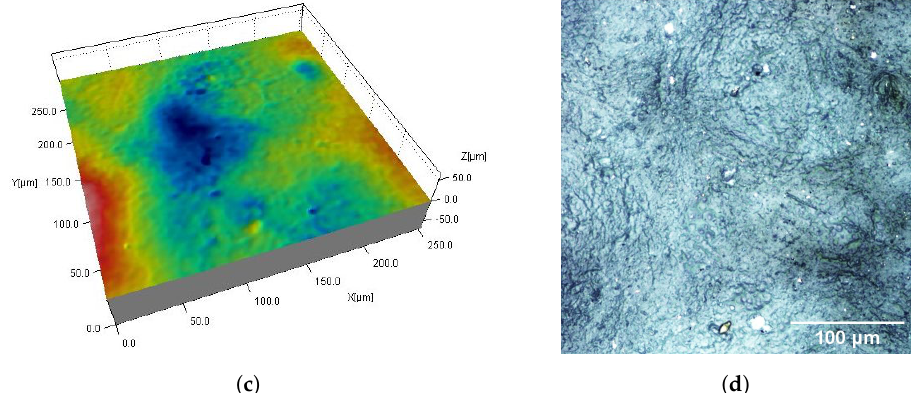
Figure 5. Surfaces of SLS samples after chemical smoothing DM_VFS_Col ( a , b ) and AMT_CVS ( c , d ): fragments 0.5 mm × 0.5 mm of 3D maps ( a , c ) and corresponding 2D views ( b , d ).